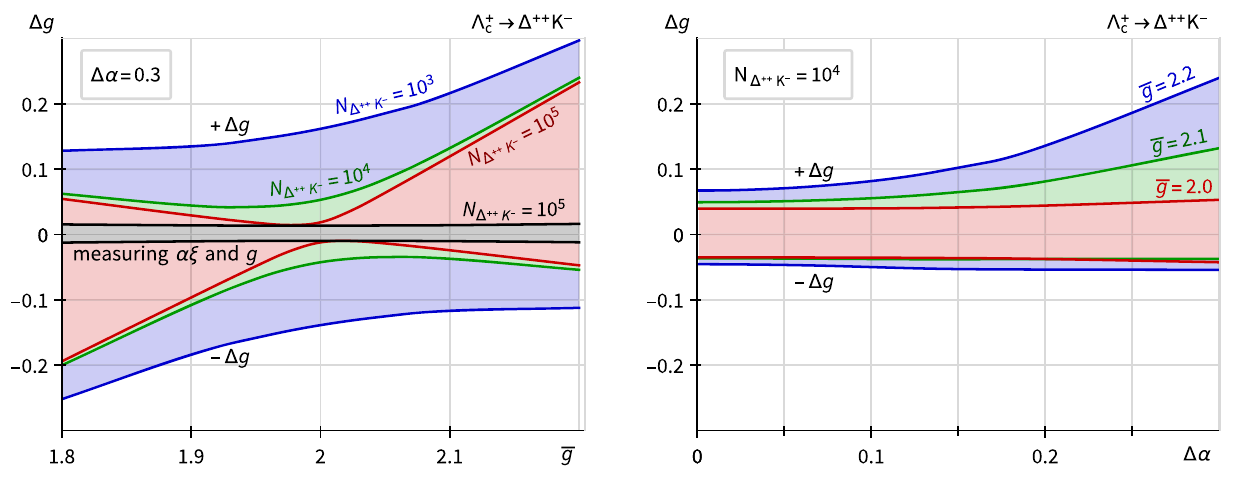
Fig. 6 Absolute error of g -factor (left) as a function of its expected value g , and (right) as a function of error on alpha parameter Δα . (Left) for different numbers of registered events and (right) for vari-